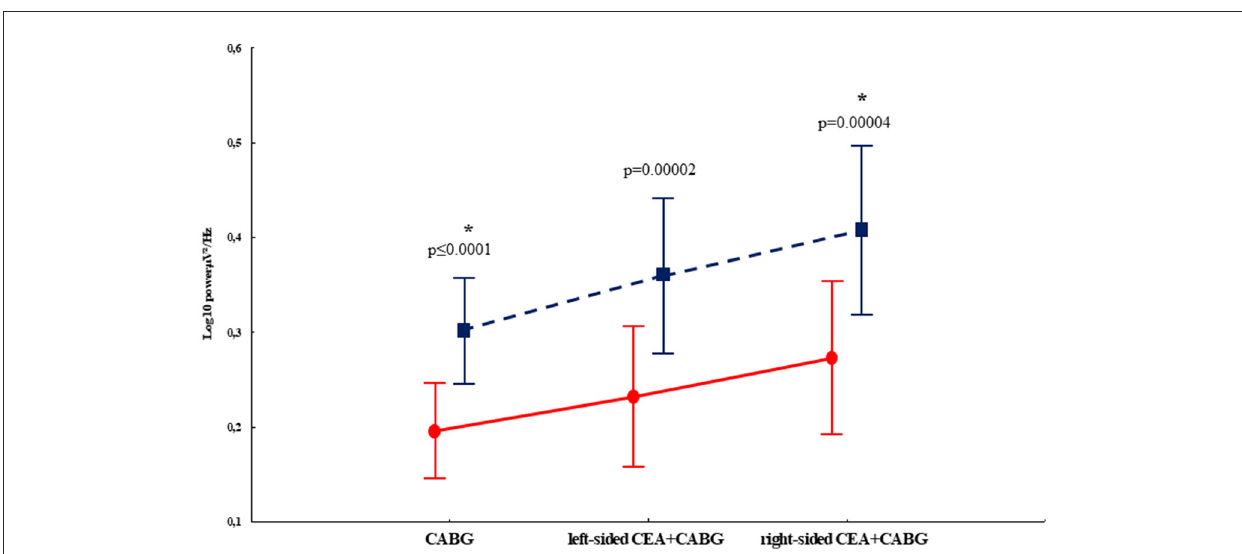
FIGURE3 Postoperative theta1 rhythm power changes in the patients undergoing isolated CABG and simultaneous intervention (CABG + CEA). Solid red lines—the preoperative indicators, and dashed blue lines—the postoperative indicators. * indicates the significance level p ≤ 0.05 in the postoperative indicators of the right-sided CEA + CABG group in comparison to the CABG